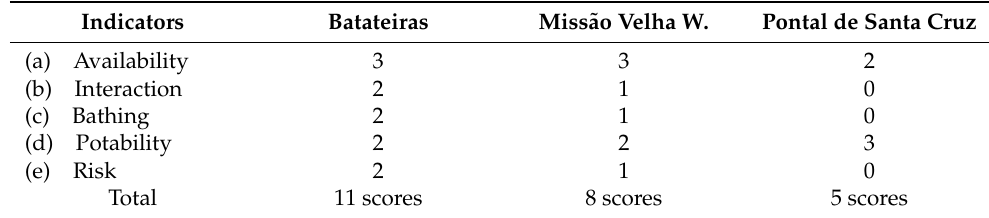
Table 1. Diversity and aquatic interaction, Batateiras, Miss ã o Velha Waterfall and Pontal de Sta. Cruz, Araripe